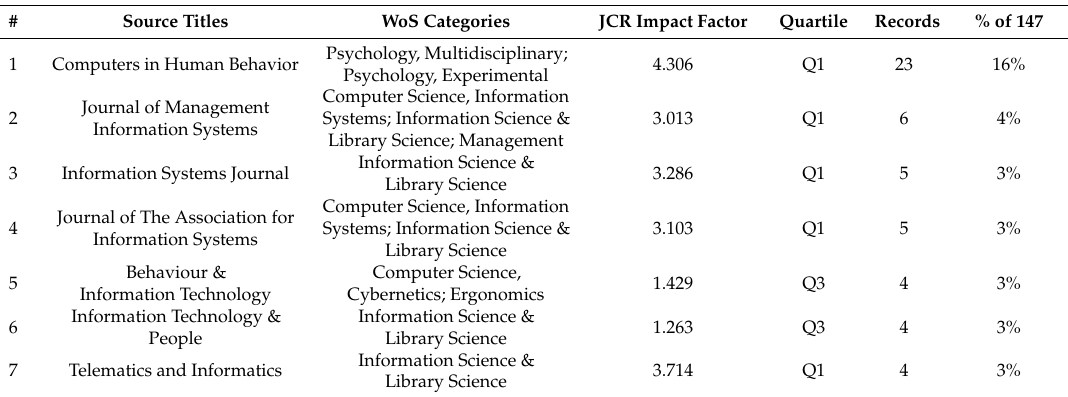
Table 4. Sources in the Bradford